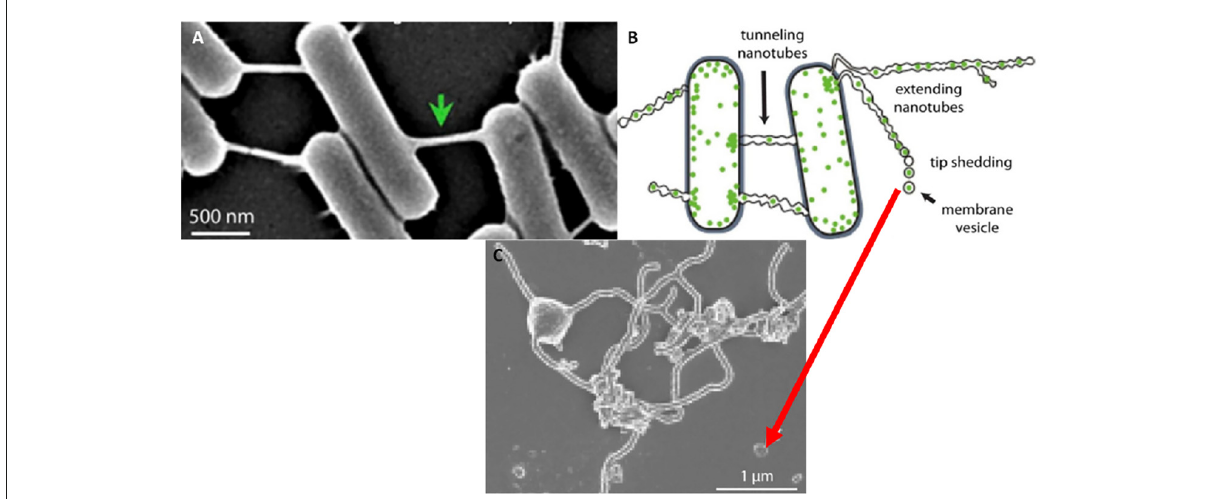
FIGURE11 The formation of the tunneling nanotube and subsequent exosomes. (A) Intercellular nanotubes formed between adjacent bacterial cells. (B) An annotated diagram of exosome generation formed as a result of budding from existing bacterial NT extensions. (C) A micrograph exhibiting exosomal detachment from NT structures (Mentor et al.,